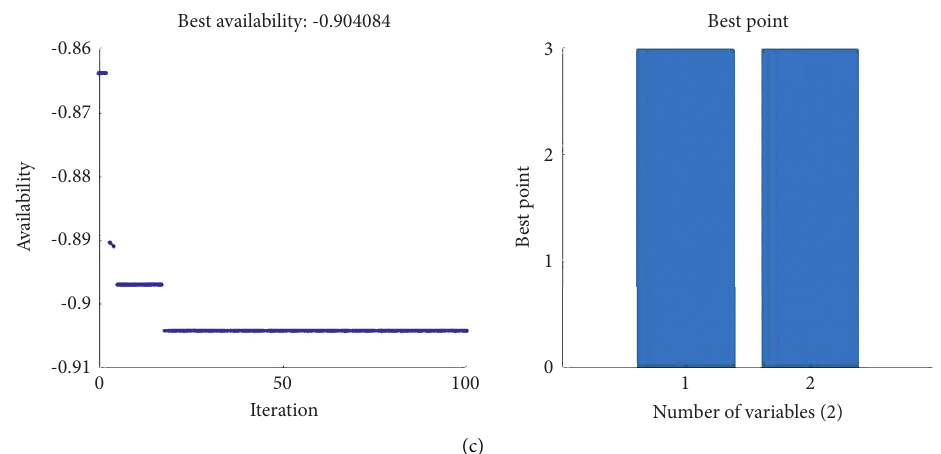
Figure 11: The iterative process of the simulated annealing algorithm.